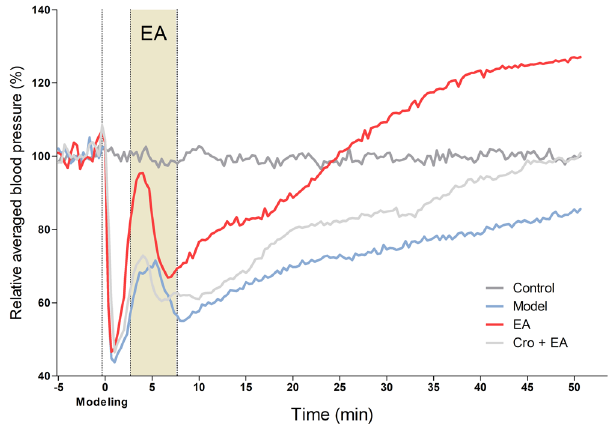
Figure 6. Relative blood pressures among different groups (n = 5–6). Blood pressure was measured at the left carotid artery. The average of 50 beats was calculated for every 20 s. The average relative blood pressures of each group are shown with different colours. An intravenous injection of pituitrin was applied to induce bradycardia 5 min after recording, indicated as “Modelling” with a dashed line. EA was applied at PC 6 at 3 min after modelling (shadow area).